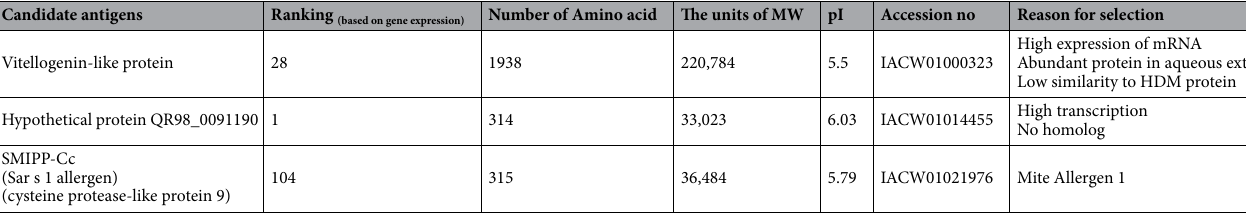
Table 3. Selection of three proteins as potential target antigens for scabies diagnosis. pI isoelectric point, HDM house dust mites.